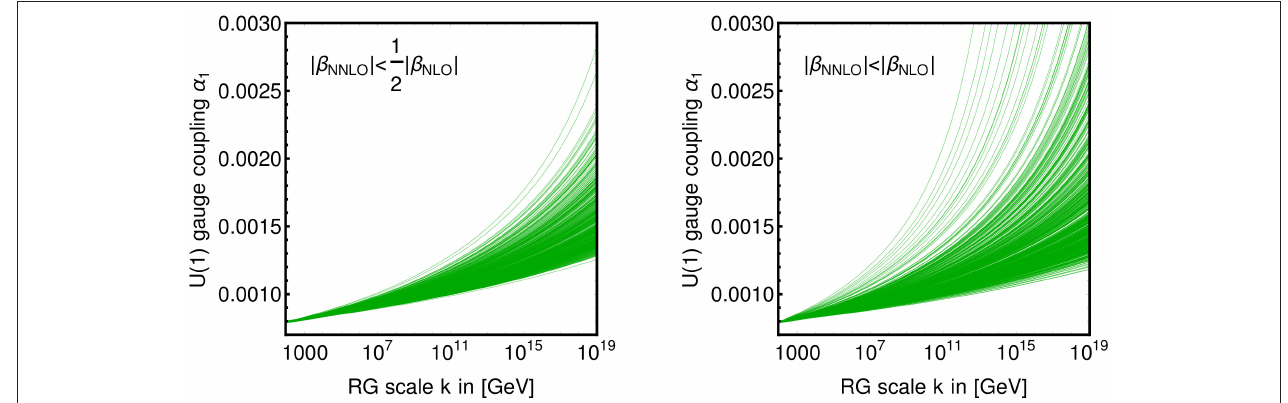
FIGURE 4 | RG-flow of the U(1) gauge coupling matched to the observed electroweak value for arbitrary non-Abelian gauge and top-Yukawa couplings within the perturbative regime. (Left) perturbativity defined by